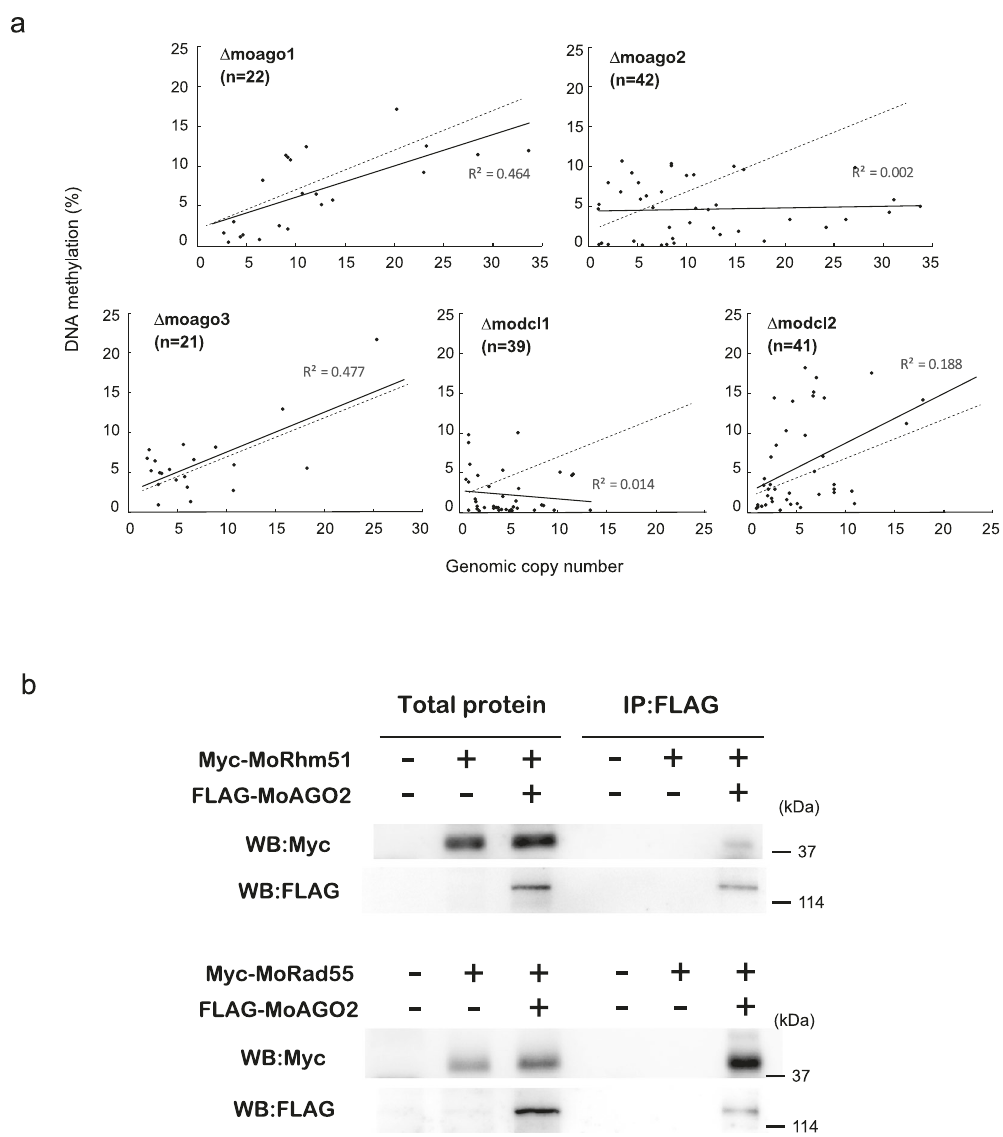
Fig. 5 A speci fi c set of RNA silencing components plays a crucial role in copy number-dependence of MAGGY methylation in P. oryzae . a Relationship between the genomic copy number and the rate of DNA methylation of MGY- Δ RT in deletion mutants of two Dicer-like genes ( Δ modcl1 and Δ modcl2) and three Argonaute genes ( Δ moago1, Δ moago2, and Δ moago3). The dashed line represents the regression lines of the wild-type strain shown in Fig. 1a. b Co-immunoprecipitation assay of FLAG-tagged MoAGO2 with Myc-tagged MoRhm51 or Myc-tagged MoRad55. Cell lysates (total protein) of P. oryzae transformants with these constructs were immunoprecipitated (IP) with anti-FLAG antibodies, followed by western blotting (WB) with an anti-FLAG or anti-Myc